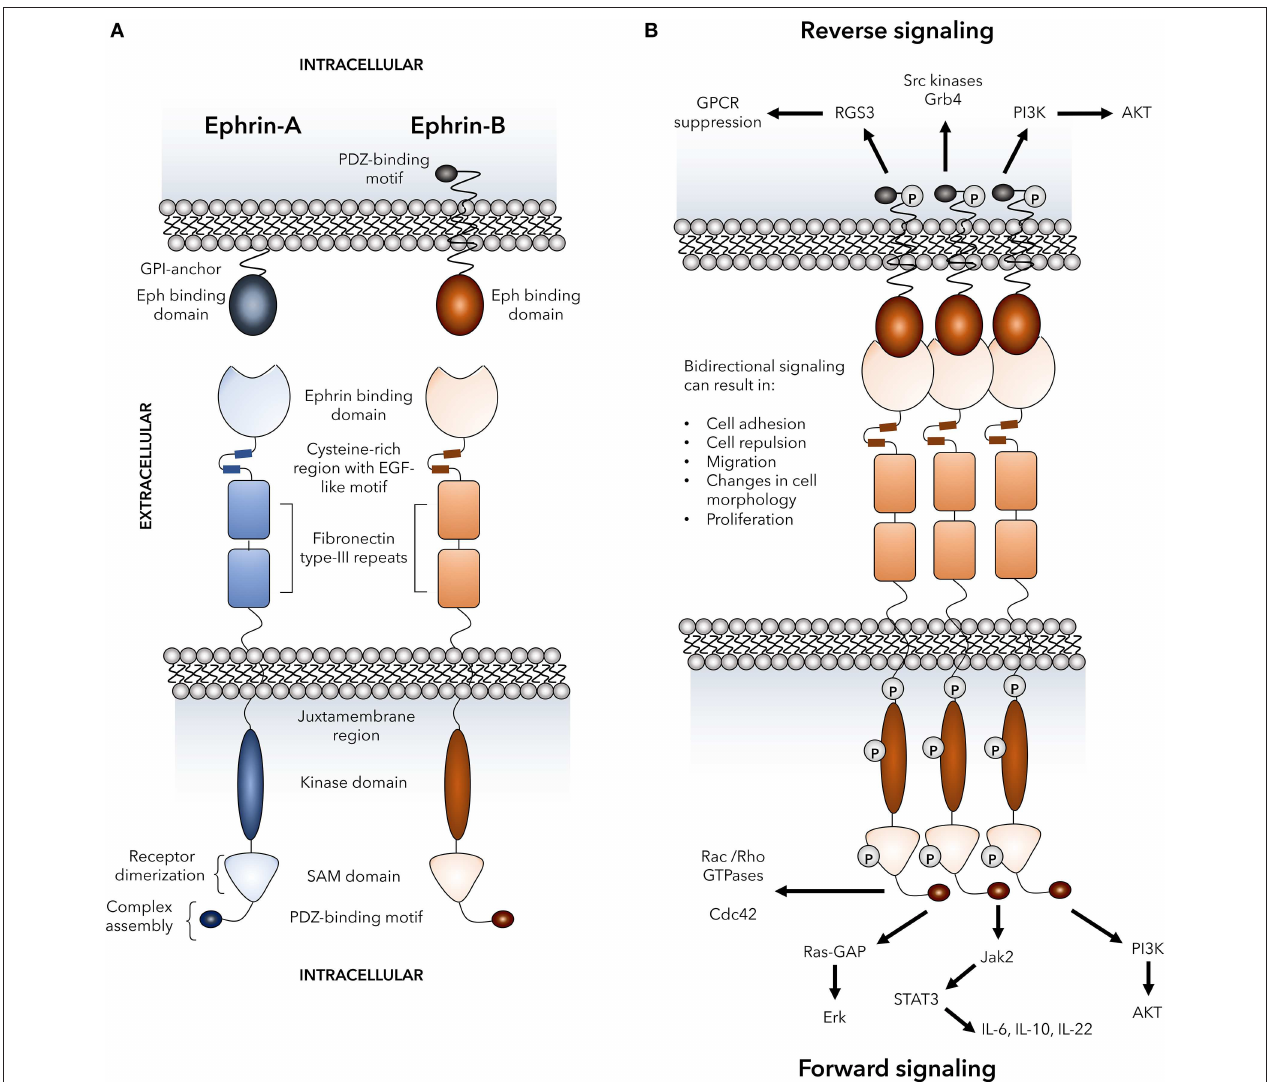
FIGURE 1 | Basic Eph receptor structure and signaling pathways. The structure of Eph receptors and their ligands is shown in (A) . Eph receptors are consisting of an extracellular structure consisting of an ephrin binding domain connected to two fibronectin type-III repeats by a cysteine-rich EGF-like motif. The juxtamembrane region connects the extracellular portion of the receptor to the intracellular kinase domain that is linked to a sterile alpha motif (SAM) domain and PDZ-binding motif. Two tyrosine residues on the juxtamembrane region mediate autophosphorylation. Eph receptors bind to ephrin ligands via an extracellular Eph binding domain. Ephrin-A ligands are GPI-anchored to the plasma membrane and signal through co-receptors that have not yet been fully defined. Ephrin-B ligands are transmembrane and are linked to an intracellular PDZ-binding motif via a linker containing five tyrosine resides for autophosphorylation. (B) Dimerization of Eph receptors is regulated by various processes including SAM domain interactions, ligand clustering, and interactions between cysteine-rich regions and ephrin binding domains on neighboring receptors. Receptor dimerization mediates the formation of heterocomplexes that are required for signaling and are assembled via the Eph receptor PDZ-binding motif. Formation of the heterocomplex mediates bi-directional signaling in which numerous signaling pathways known to play a role in immune cell function can be activated through both ephrin “reverse” and Eph “forward” signaling. These signaling events include activation of Rho GTPases, MAP kinases, PI3 kinase, Src family kinases, Jak-STAT molecules, and RGS3 that has been shown to suppress G-protein coupled receptors including chemokine receptors. P, representative of tyrosine phosphorylation sites; GPCRs, G-protein coupled receptors; RGS3, regulator of G-protein signaling 3; Grb4, cytoplasmic protein NCK2; PI3K, phosphatidylinositol 3-kinase; AKT, protein kinase B; Cdc42, cell division control protein 42 homolog; Ras-GAP, Ras-GTPase-activating protein; Erk, extracellular signal-regulated kinases; Jak, Janus kinase; STAT, signal transducer and activator of transcription; IL, interleukin.